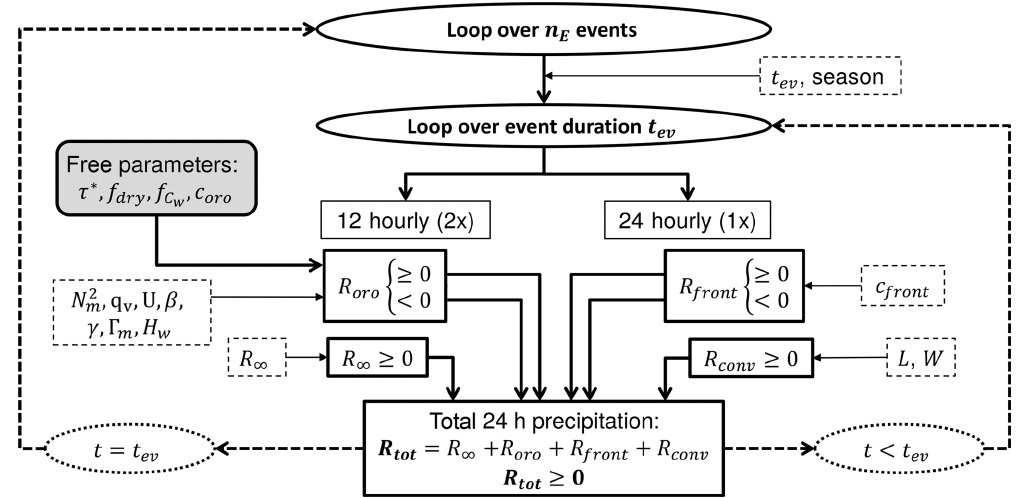
Figure 6. Flow chart of the individual components of the SPM2D (solid boxes) and the corresponding input variables (PDFs; dashed boxes). Loops are highlighted as ellipsis or bold dashed arrows. The constant model parameters are illustrated as the shaded